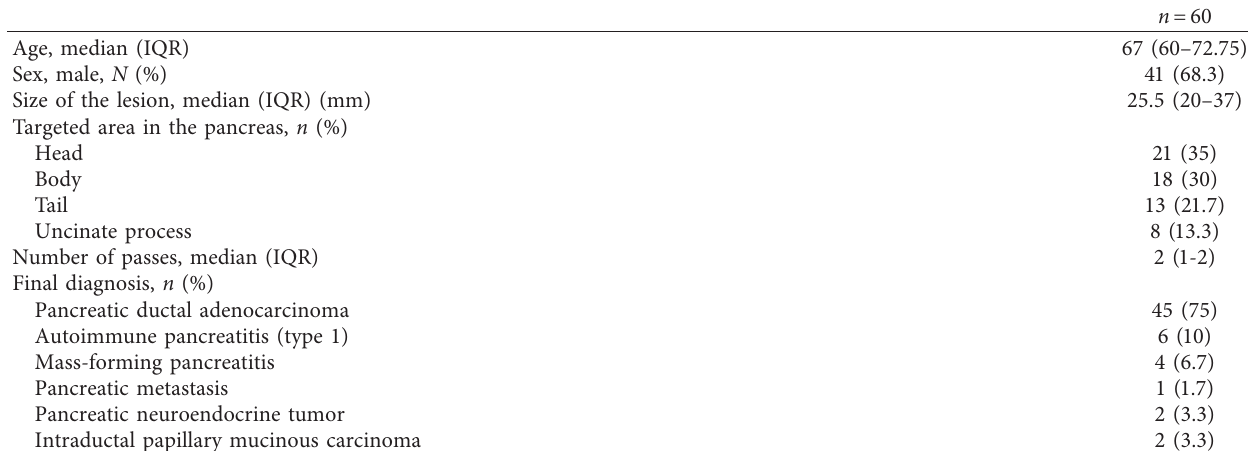
Table 1: Patient characteristics.